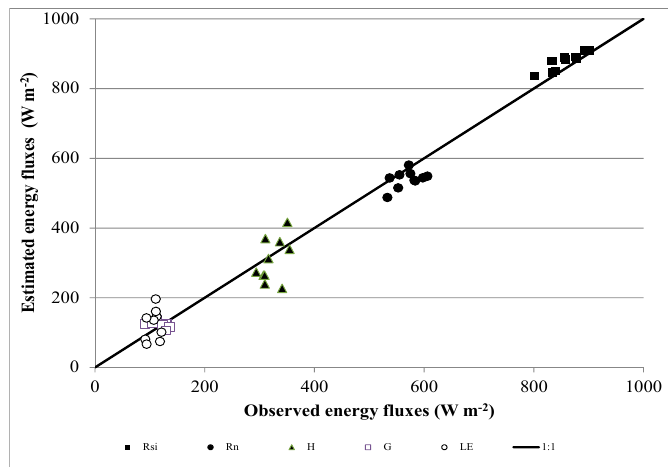
Figure 6. Comparisons at the time of UAV overpass between observed (axis X) and estimated (axis Y) values of bulk (canopy and soil) incoming solar radiation (Rsi) net radiation (Rn), soil heat flux (G), sensible heat flux (H), and latent heat flux (LE) over a drip irrigated olive orchard. Table 3. Validation of sub-models that compute solar radiation (Rsi), net radiation (Rn), sensible heat flux (H), soil heat flux (G) and latent heat flux (LE) over a drip-irrigated olive orchard at the time of UAV overpass.